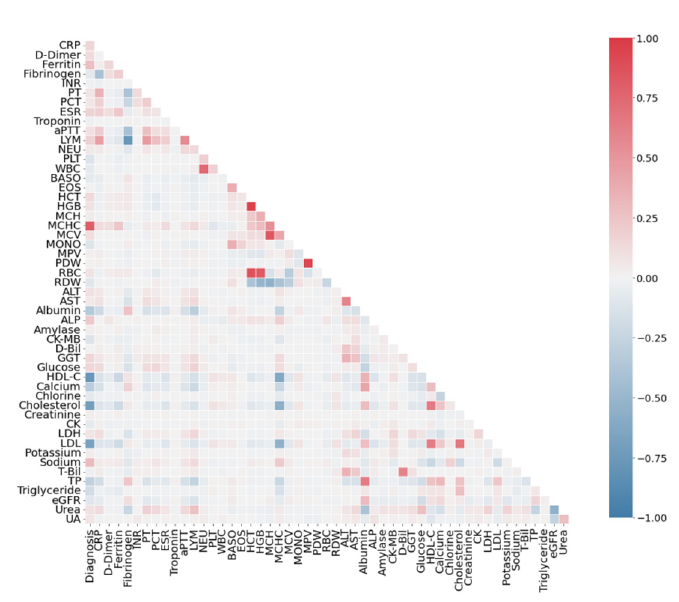
Figure 2. Correlation of the SARS-CoV-2-RBV1 dataset for diagnosis–feature (point-biserial correla- tion) and feature–feature pairs (Pearson coefficient).